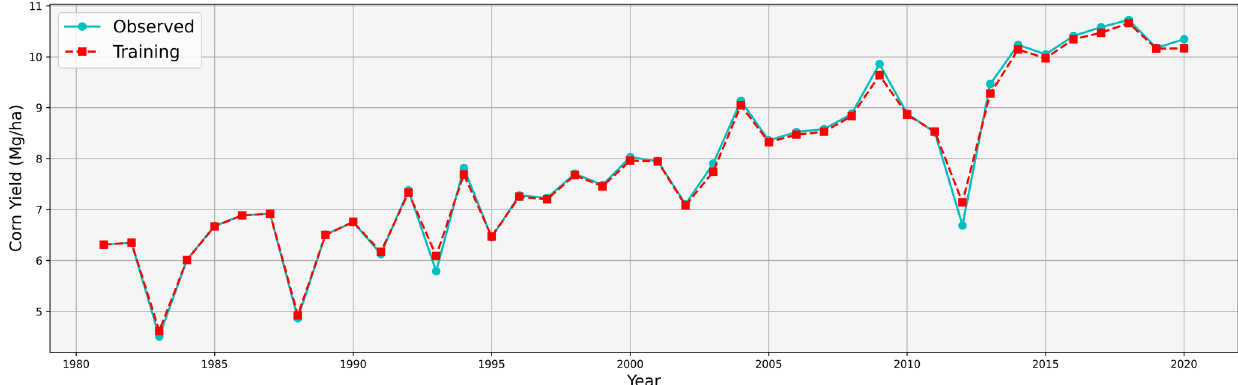
Fig. 2 Training performance of proposed model. The cyan and red curves are, respectively, observed yield and fi tted yield using training data between 1981 and 2020, averaged across all counties in the Corn